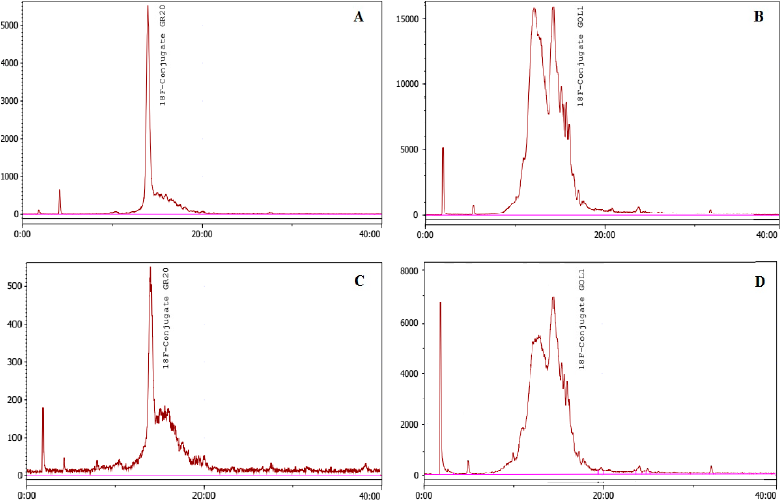
Figure 3. Click reaction without the TBTA ligand. HPLC profiles of the [ 18 F]FB-GR20 conjugate (( A )—before and ( C )—after purification on NAP-5) and the [ 18 F]FB-GOL1 conjugate (( B )—before and ( D )—after purification on NAP-5). Conditions: Phenomenex Luna C8 column (5 μ m, 4.6 × 150 mm); mobile phase: linear gradient starting with 90% eluent A (0.1 M triethylammonium acetate in water) and 10% solvent B (acetonitrile) with replacement by 70% eluent A and 30% eluent B at 35 min; flow rate 1 mL/min.